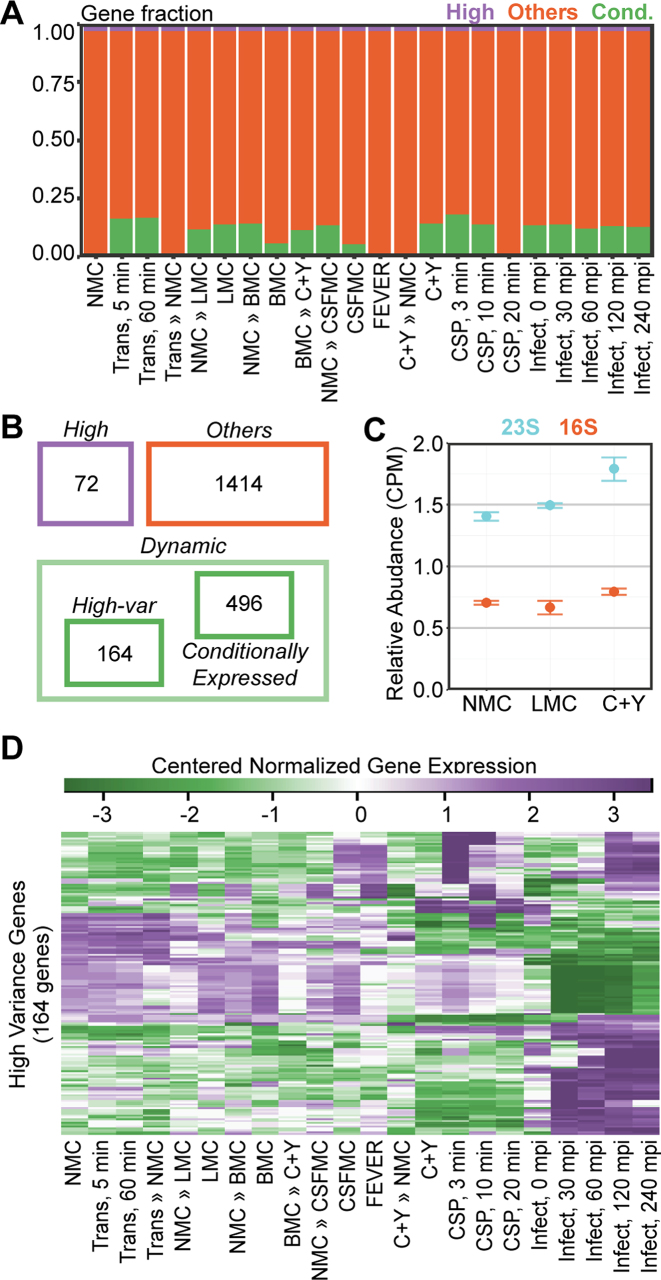
Categorization of genes. (A) Visualization of the number of genes in all conditions according to their categories: steadily highly expressed (purple), conditionally expressed (green) and others (orange). Of the 2146 features, 73 are classified as highly expressed, while 498 features are conditionally expressed (lowly expressed in at least one condition). (B) Highly expressed genes include essential genes, genes encoding ribosomal proteins and rRNAs. Dynamic genes are a combination of the 164 high-variance genes and 498 conditionally expressed genes. (C) The 23S rRNA was significantly downregulated in nose-mimicking (NMC) and lung-mimicking (LMC) growth compared to rich C+Y growth (P < 0.05). The 16S rRNA showed a similar trend, but it was not statistically significant (P = 0.33, C+Y to NMC; P = 0.83, C+Y to LMC; error bars represent standard error). (D) Expression values (regularized log) of high-variance genes were centered, as described in Supplementary Materials and Methods, and plotted as heat maps. Distinct clusters of gene expression can readily be observed (purple: high expression, green: low expression).